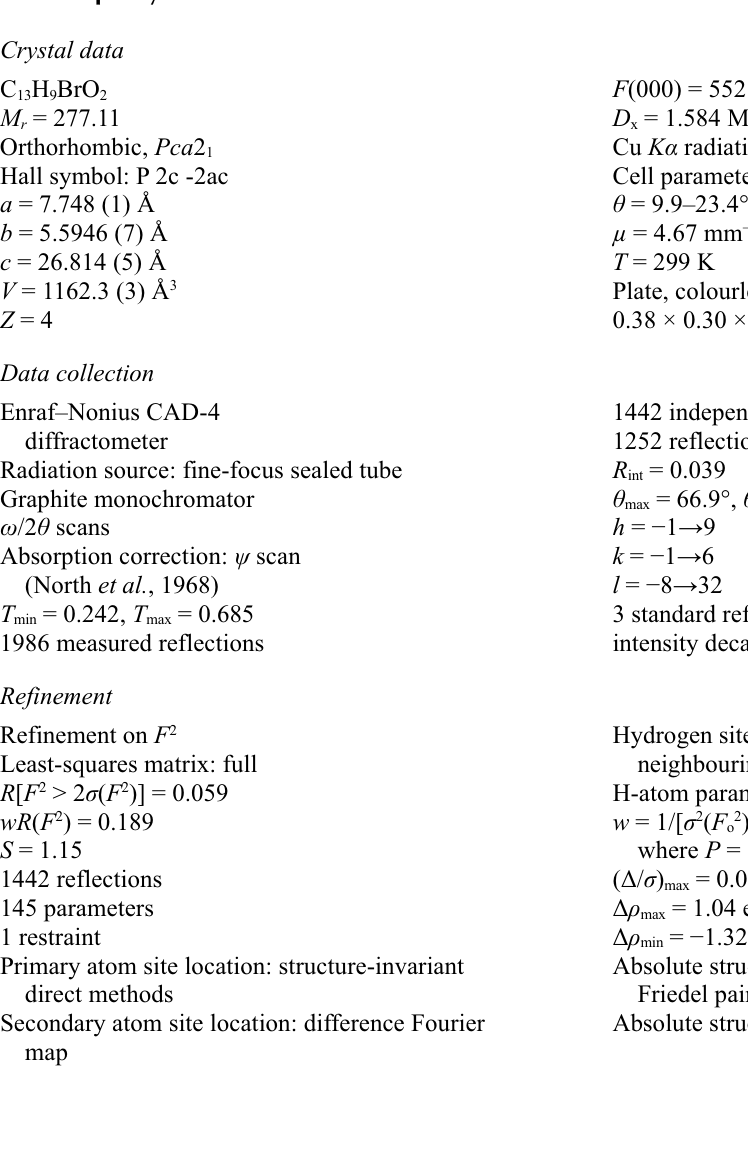
Figure 2 Molecular packing of the title compound as viewed down the bc plane. 4-Bromophenyl